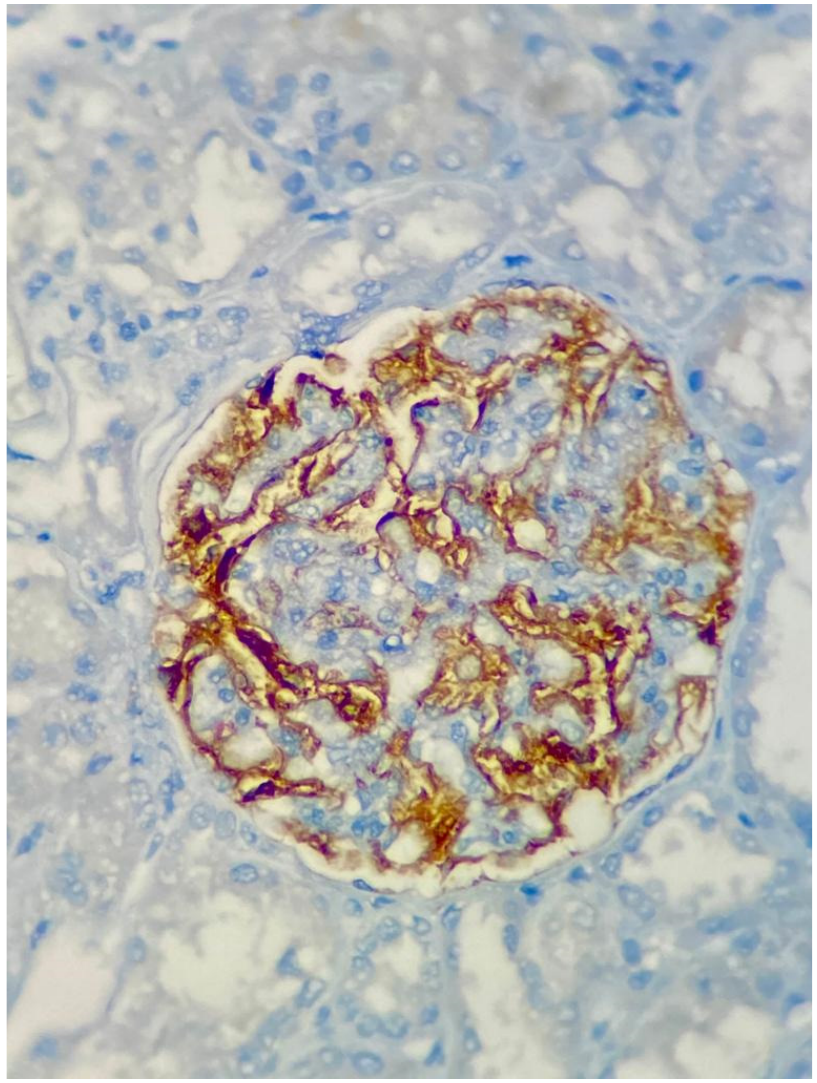
Figure 1. Representative immunohistochemistry for a positive anti-PLA2R in MN kidney biopsy.